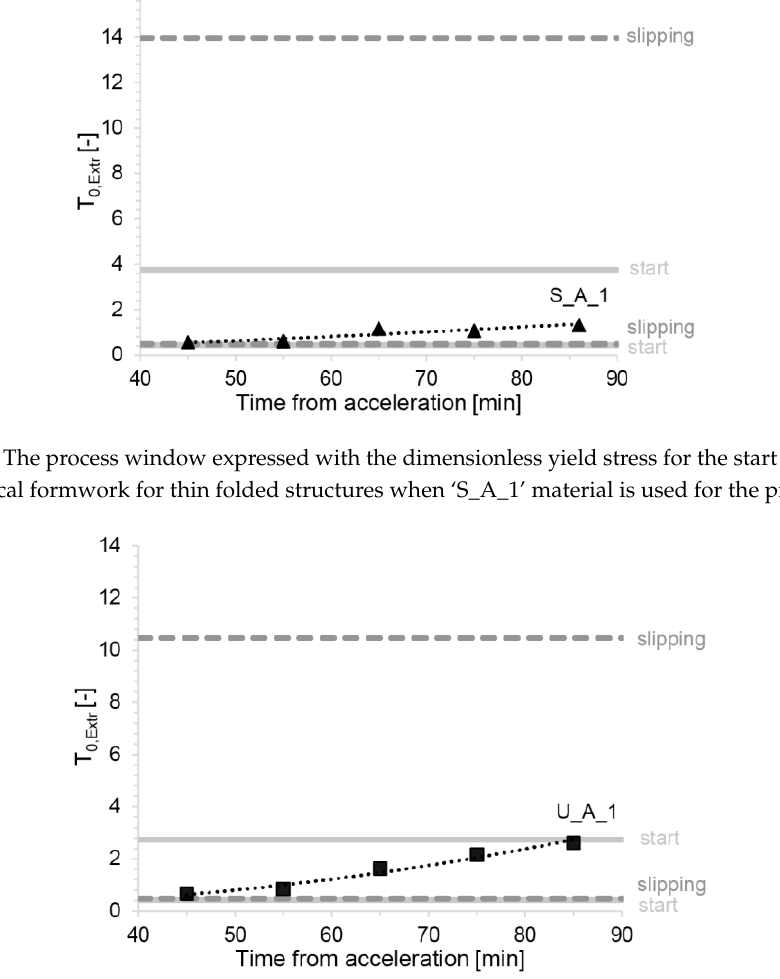
Figure A3. The process window expressed with the dimensionless yield stress for the start of slipping with a typical formwork for thin folded structures when ‘U_A_1’ material is used for the process.